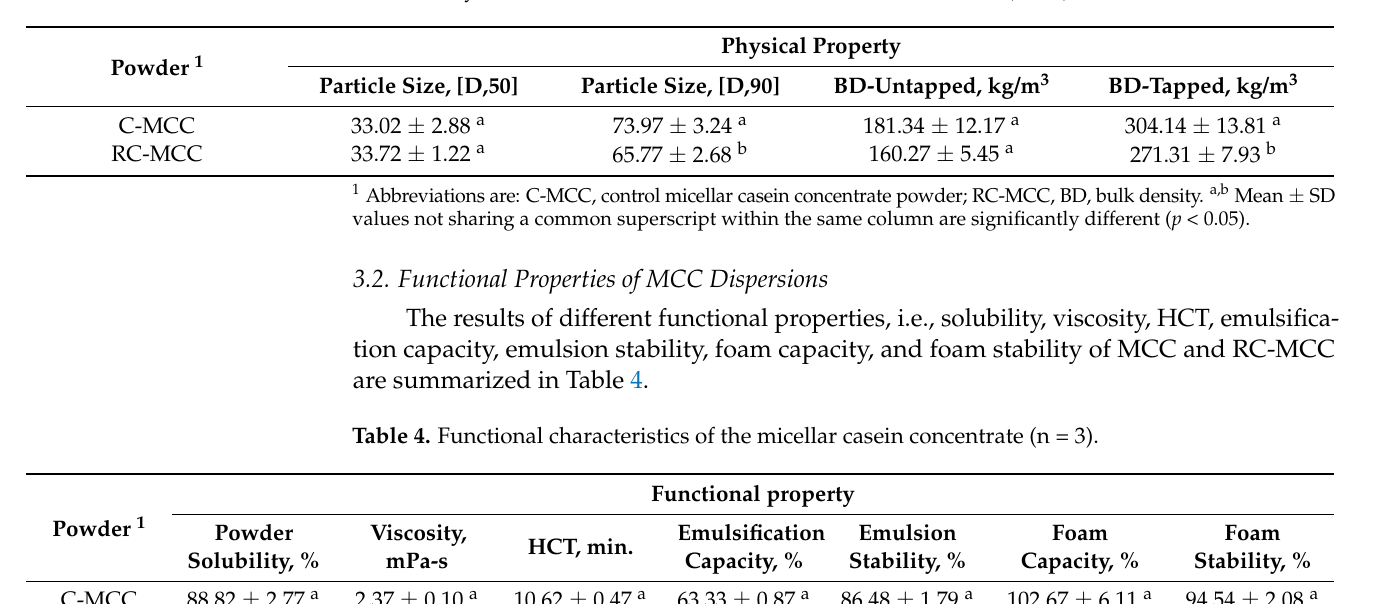
Table 3. Physical characteristics of the micellar casein concentrate (n = 3).